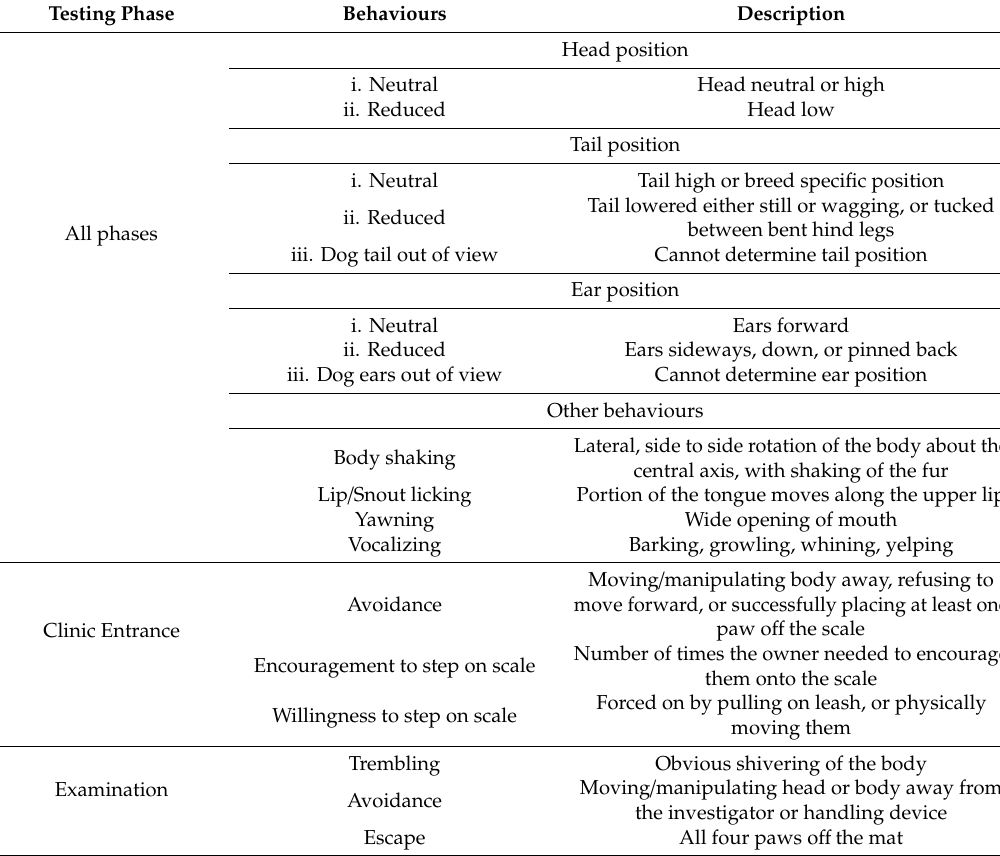
Table 3. Ethogram of behaviours scored during all stages of the veterinary